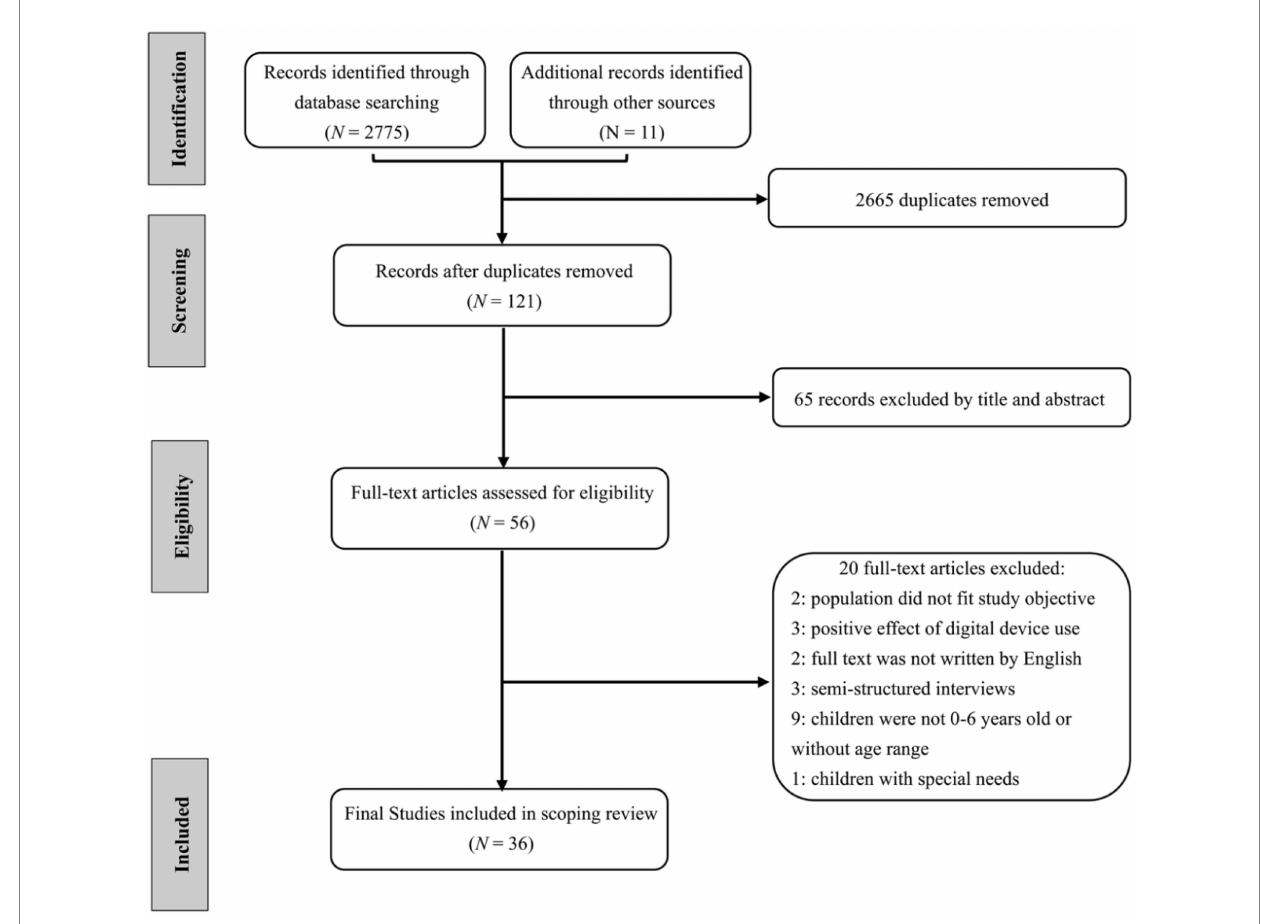
FIGURE 2 The selection of studies included in this scoping